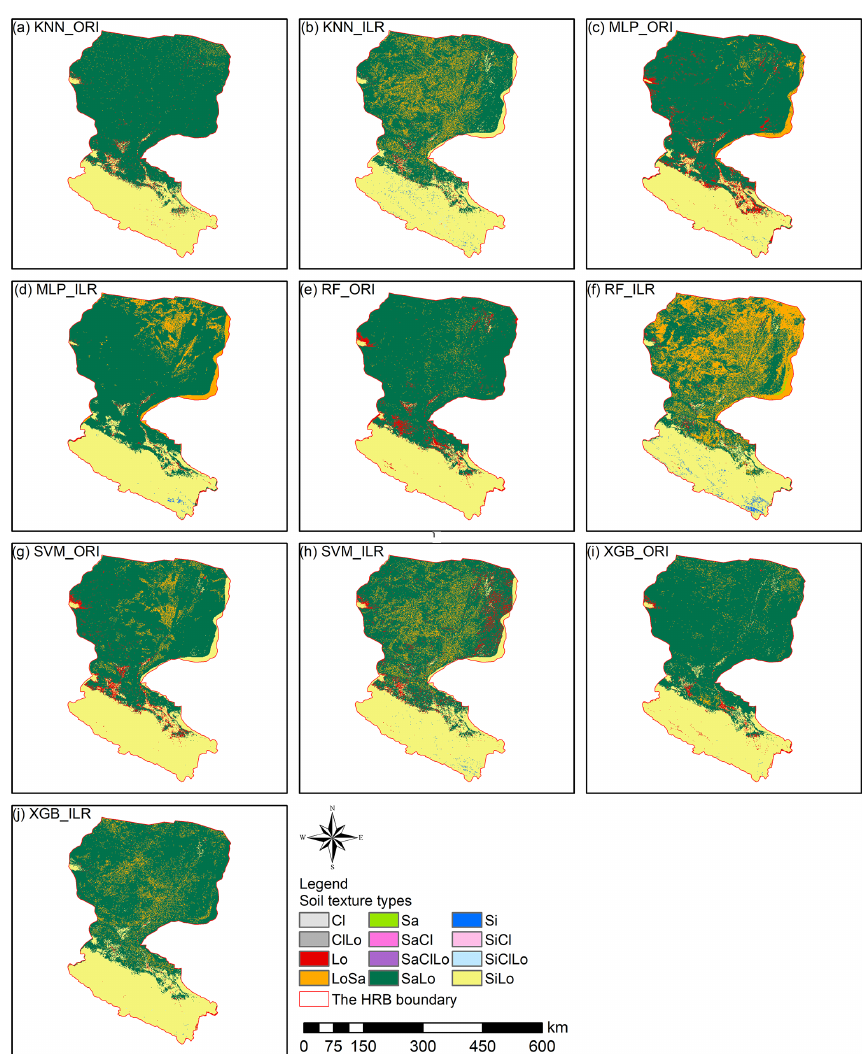
Figure 9. The prediction maps of soil texture classification by indirect methods using KNN, MLP, RF, SVM, and XGB with either ILR- transformed data (ILR) or original data